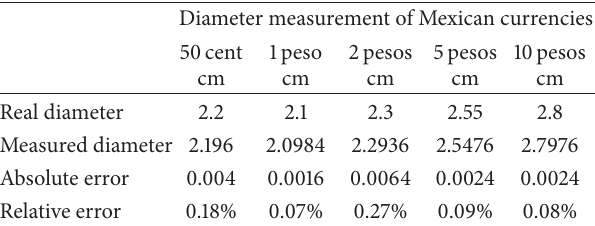
Table 1: Diameter